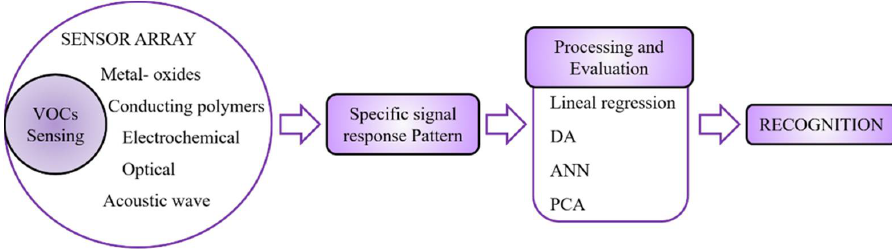
Figure 1. Schematic workflow of an e-nose system.